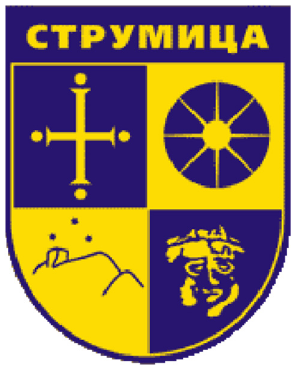
Figure 14. Arms with sun with convergent rays.